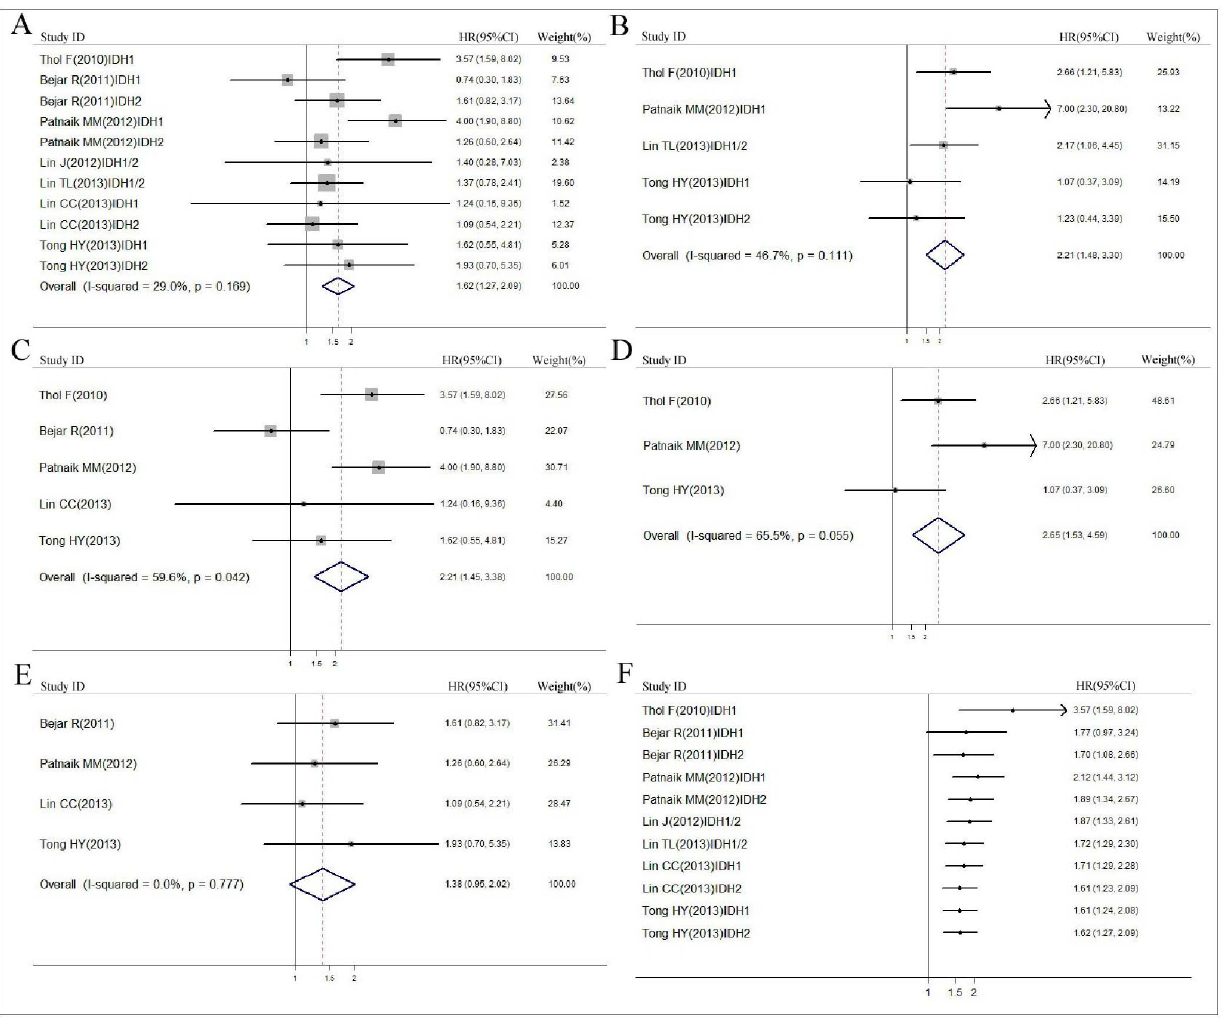
Figure 4. Forest plots describing the association between IDH mutations and MDS. (A) Forest plots of HR and 95% CI for IDH1/2 mutations in MDS comparing with IDH wild-type by OS endpoints. (B) Forest plots of HR and 95% CI for IDH1/2 mutations in MDS comparing with IDH wild-type by LFS endpoints. (C) Forest plots of HR and 95% CI for IDH 1 mutations in MDS comparing with IDH 1 wild-type by OS endpoints. (D) Forest plots of HR and 95% CI for IDH 1 mutations in MDS comparing with IDH 1 wild-type by LFS endpoints. (E) Forest plots of HR and 95% CI for IDH 2 mutations in MDS comparing with IDH 2 wild-type by OS endpoints. (F) Forest plots of cumulative meta-analysis of IDH mutations in association with MDS for OS by published